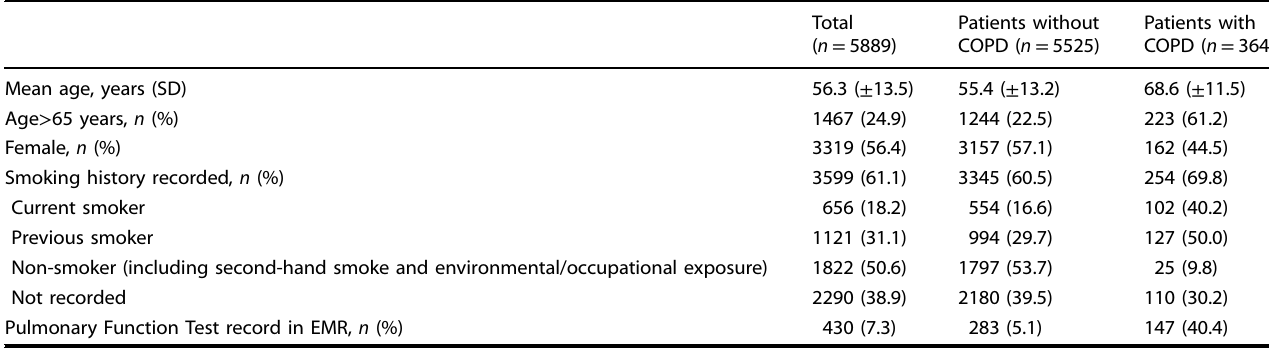
Table 1. Study cohort characteristics by COPD diagnosis derived from primary care electronic medical record chart abstraction